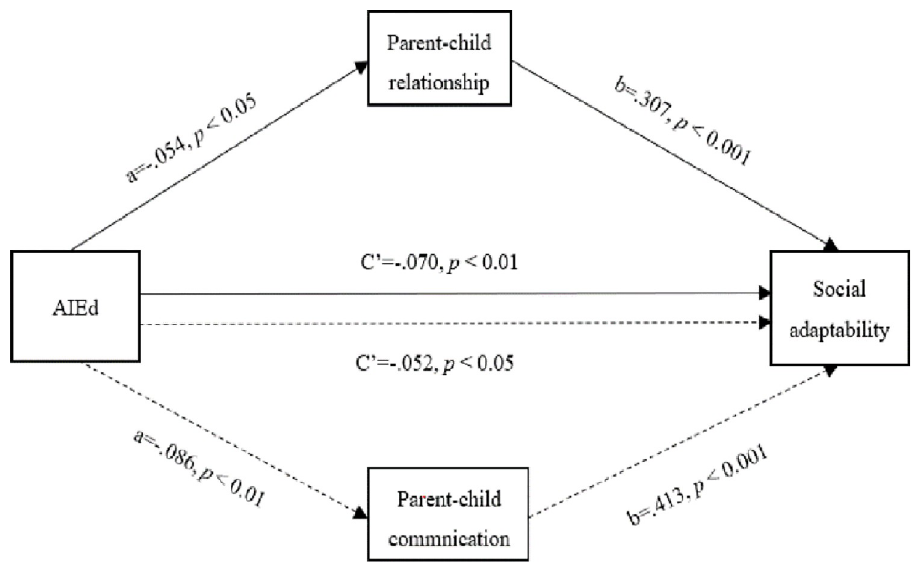
Fig 2. Mediatory model of family support system between AIEd and social